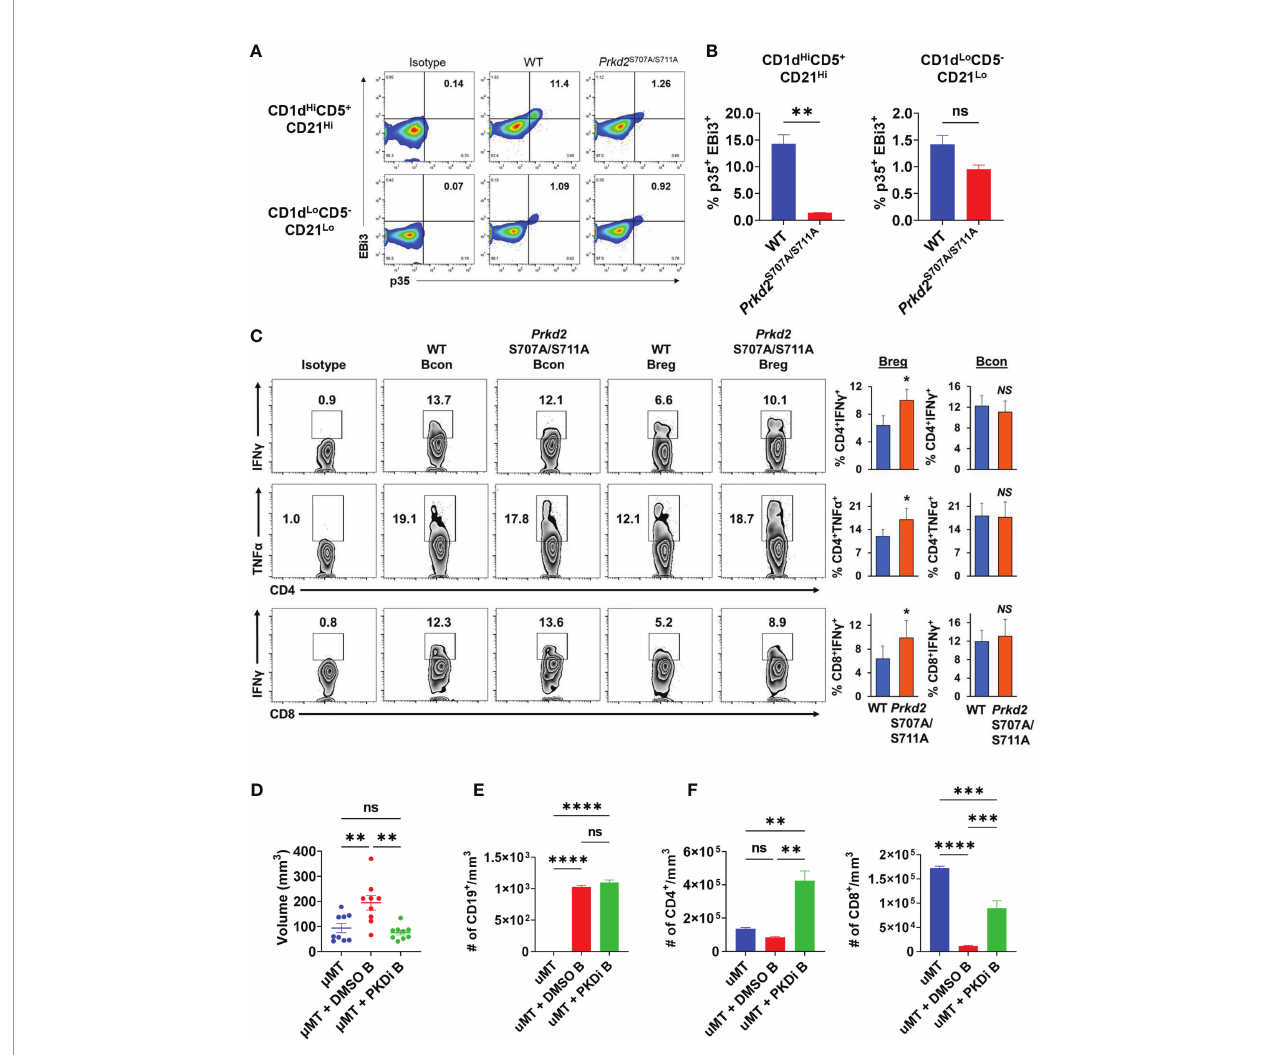
FIGURE 6 | Inhibition of B cell PKD function suppresses IL-35 expression and tumor growth. (A) Representative fl ow cytometry plots of intracellular EBi3 and p35 in WT and homozygous Prkd2 S707A/S711A CD19 + CD21 Hi CD1d Hi CD5 + and CD19 + CD21 Lo CD1d Lo CD5 - splenic B cells stimulated for 48 hours with LPS + a IgM + a CD40 ex vivo . N=4. (B) Frequency of p35 + EBi3 + B cells from (A) . N=4. (C) Intracellular fl ow cytometry of IFN g and TNF a from CD4 + and CD8 + T cells co-cultured in contact-independent transwells with either WT or homozygous Prkd2 S707A/S711A CD19 + CD21 Hi CD1d Hi CD5 + regulatory B cells. N=3. (D) Orthotopic KPC4662 tumor volumes of µMT mice reconstituted with DMSO or CRT0066101 (PKDi) treated WT splenic B cells. N=9. Cumulative of 2 independent experiments. (E) Quanti fi cation of intratumoral CD19 + B cells per mm 3 of tumor by fl ow cytometry from mice in (D) . N=5. (F) Quanti fi cation of intratumoral CD4 + T cells (left) and CD8 + T cells (right) per mm 3 of tumor by fl ow cytometry from mice in (D) . N=5. Error bars indicate SEM; p values in (B, C) were calculated using unpaired t-test; p values in (D – F) were calculated using one-way ANOVA; p values in (G) were calculated using two-way ANOVA. NS, non-signi fi cant, *p<0.05, **p<0.005, ***p<0.001, ****p<0.0001. Experiments were performed using 7 – 8-week-old mice of indicated